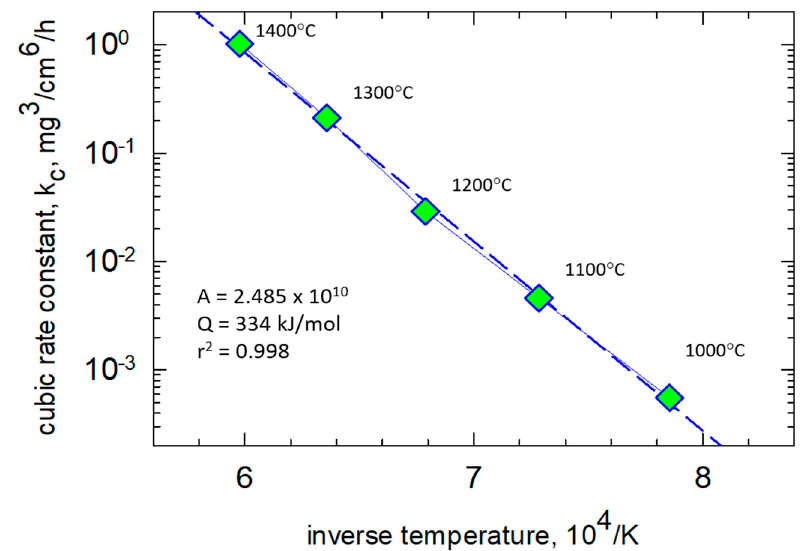
Figure 2. Arrhenius plot of log cubic oxidation rate constant vs 1/T; TGA furnace tests of Ti 2 AlC in dry air for 100 h at 1000–1400 °C [14].